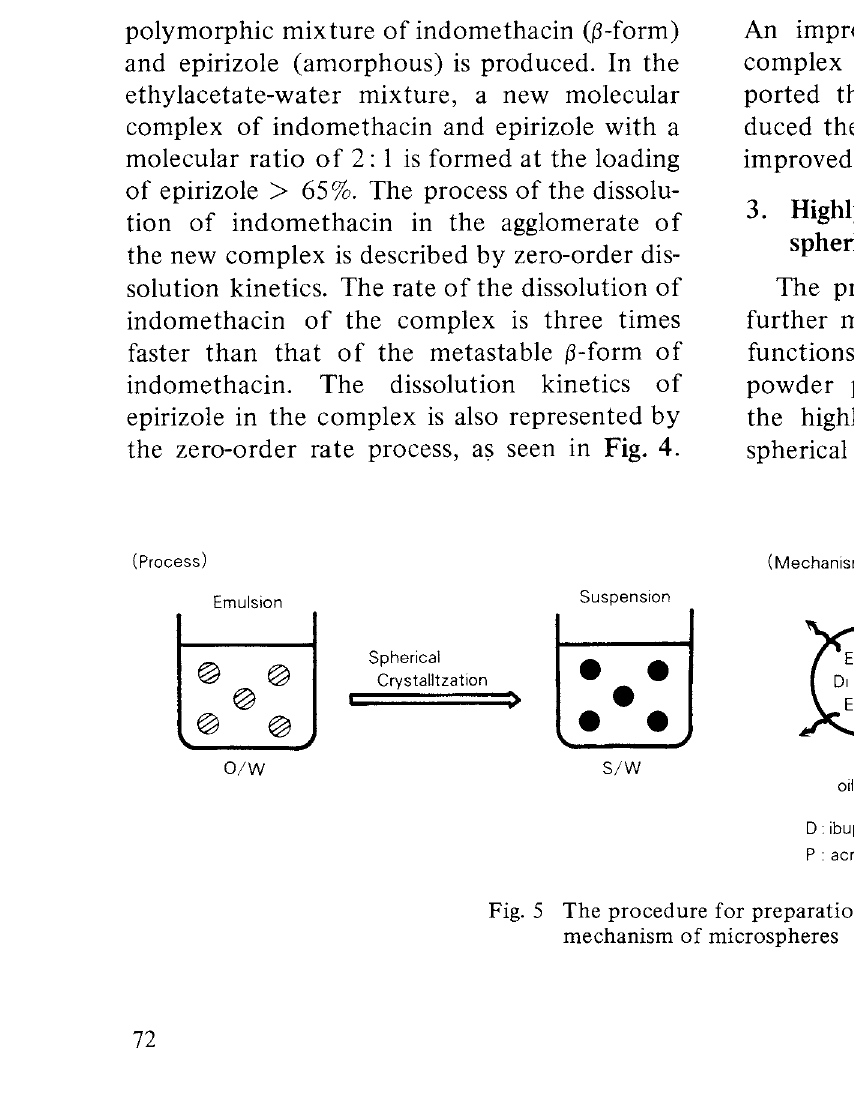
Fig. 4 Dissolution profiles of indomethacin (A) and epirizole (B) in JPX disintegration test solution 2 at 37°C by a rotating disk method.